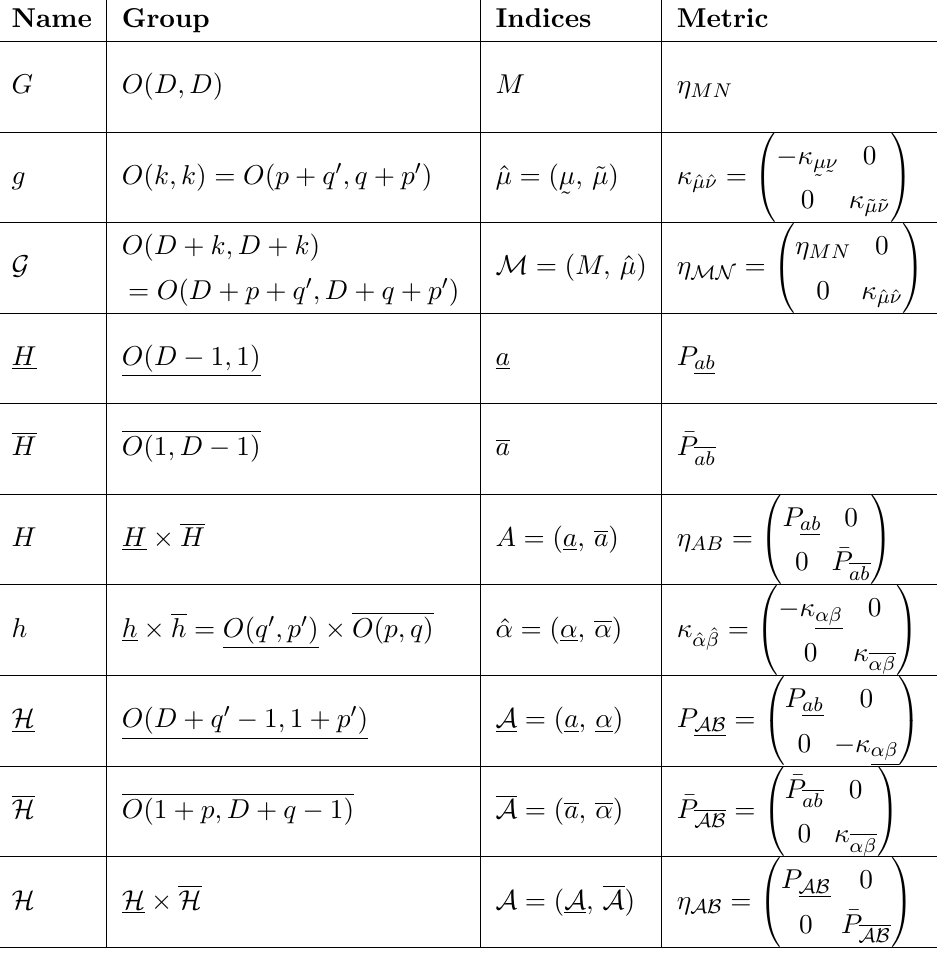
Table 2 . Groups, metrics and index structure for the extended space relevant to the bi-parametric case. In the bi-parametric case the relevant choice is q 0 = q , p 0 = p and k = p + q . If the prime quantities were independent and set to zero, this table then reproduces table